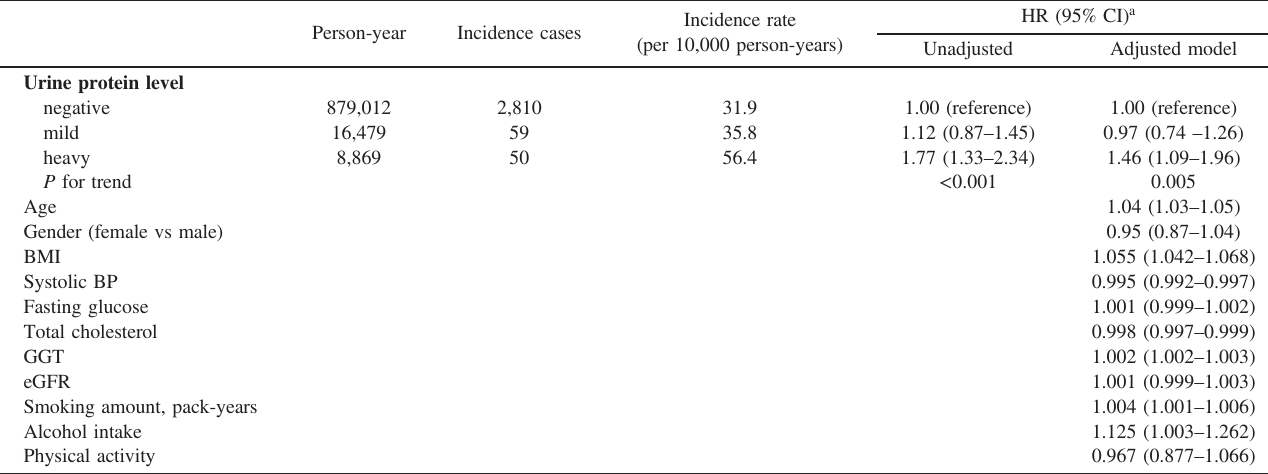
Table 3. Hazard ratios for the incidence of cholelithiasis according to the three groups of urine protein level Person-year Incidence